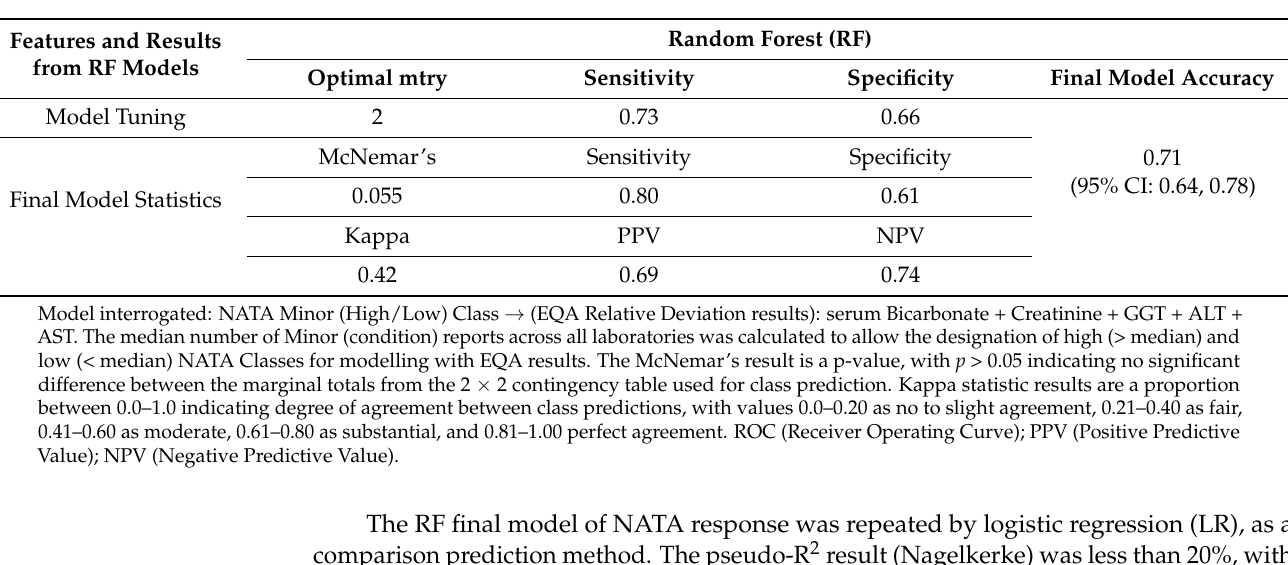
Figure 5. Random Forest (recursive partitioning) analyses that interrogated a combined serum creatinine-electrolyte and LFT (EQA relative deviation) model to determine the best predictors of NATA class (NATA Minor-High or Low Condition reports). The analysis used leading predictors from separate models (Figures 2 and 3), namely, GGT, AST, ALT, creatinine and sodium bicarbonate. Tuning and the predictive features of the random forest modelling are presented in Table 5. The combined EQA marker model accuracy and prediction values (Table 5) were not superior to the separate creatinine-electrolyte and LFT models (Tables 2 and 4). Table 5. Statistical and final predictive model tuning parameters for the random forest analyses presented in Figure 3 that interrogated the combined serum creatinine-electrolyte + LFT (EQA relative deviation) data, to determine the best predictors of NATA class (High or Low Minor Condition